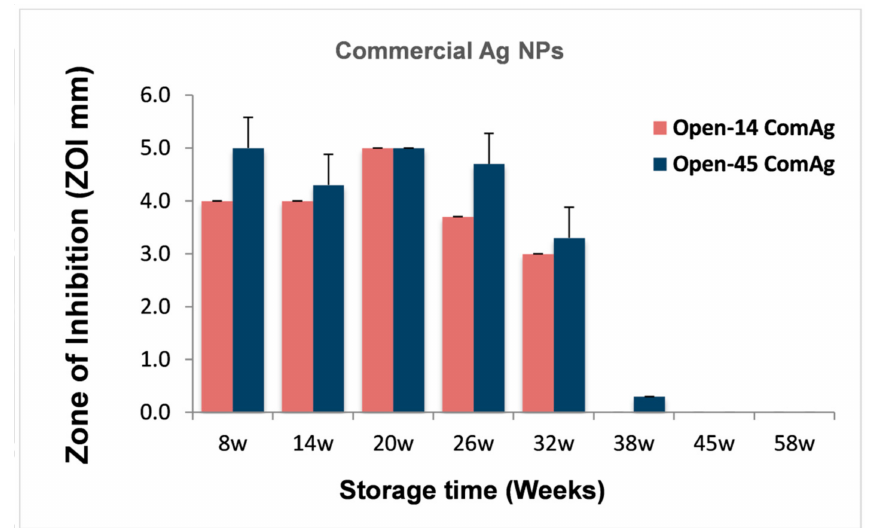
Figure 4. The effect of frequent air exposure on the antibacterial effect of the chemically produced AgNPs. The antibacterial effects of the chemically produced AgNPs that were purchased from a commercial source (Com.Ag) were determined every 14 days (Open-14) or every 45 days (Open-45) using the well-diffusion method, and results were presented when the measurement were conducted in the same week of storage. Data are mean ± SE, n =